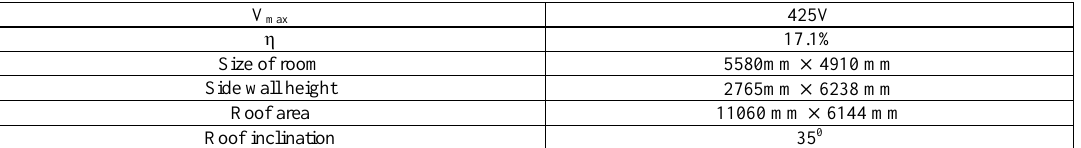
Table 1. Specification of proposed